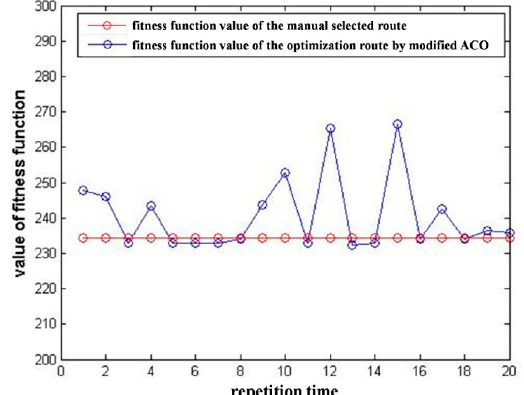
Figure 11. The final fitness function values after 1000 iterations with 20 repetitions of the modified ACO.